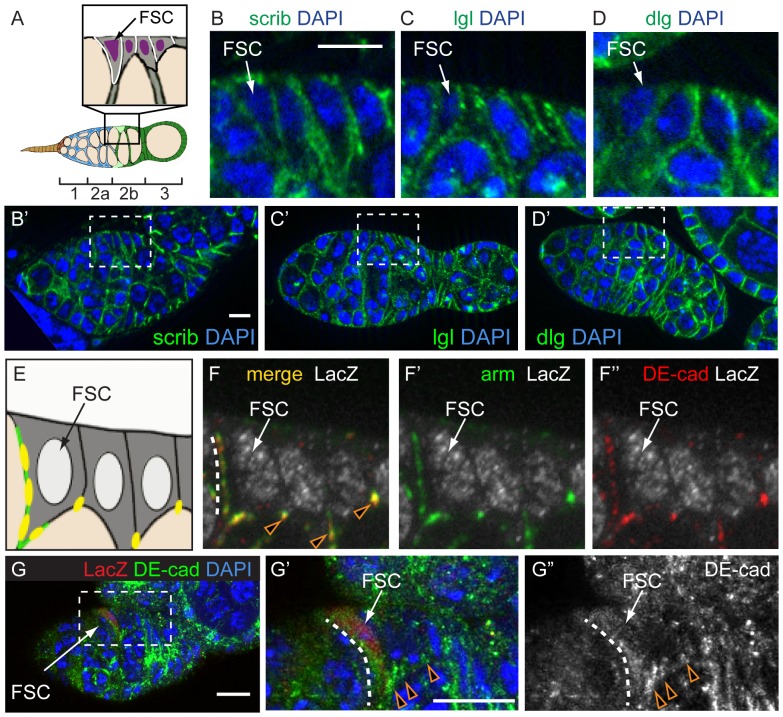
FSCs have basolateral junction proteins and broadly distributed adherens junctions.
A. Diagram of the Drosophila germarium. Inset shows the localization of Lgl, Dlg and Scrib in follicle cells (white), which is similar in FSCs and downstream follicle cells. B–D. Wildtype germaria stained for Scrib (B), Lgl (C), or Dlg (D) (green) and DAPI (blue). The regions inside the dashed boxes in B′–D′ are magnified in B–D. E. Diagram summarizing the co-localization (yellow) of Arm (green) and DE-Cad in follicle cells. F–G. Germaria with a mature LacZ+ FSC clone (white) stained for Arm (green) and DE-Cad (red). F. Adherens junctions are distributed broadly in FSCs (white dotted line) and are restricted to the apical-lateral junctions in downstream follicle cells (orange triangles). The arm and DE-cad channels are shown separately with the LacZ channel in F′ and F″, respectively. G. A Notum-LacZ germarium stained for LacZ (red) to identify the FSC, DE-cad (green) and DAPI (blue). The boxed region in G is magnified in G′ and G″. Again, DE-cad is distributed in a broad streak along the anterior lateral surface of the FSC (white dotted line) and restricted to the apical-lateral junctions in downstream follicle cells (orange triangles). Anterior is to the left. Scale bar represents 5 µm.